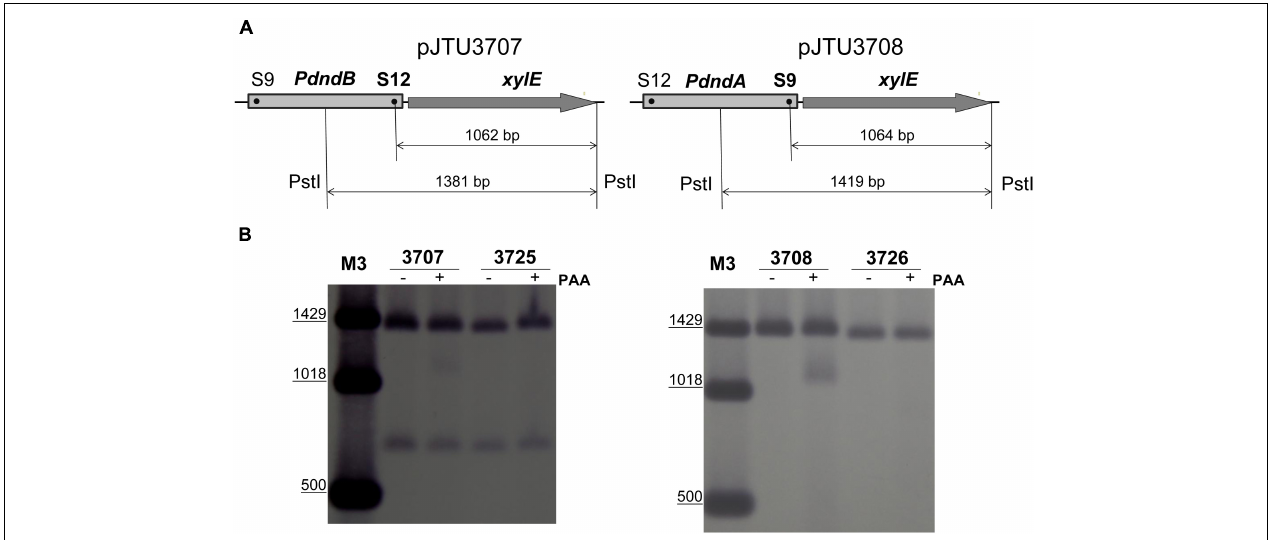
FIGURE 2 | Validation of S9 and S12 sulfur-modified sites. (A) Validation scheme for the S9 and S12 sulfur-modified sites. Genomic DNA samples from 1326/pJTU3707, 1326/pJTU3725, 1326/pJTU3708, and 1326/pJTU3726 were, respectively, subjected to digestion with Pst I, followed by treatment with PAA. pJTU3707, PdndB-xylE reporter plasmid; pJTU3725, pJTU3707 derivative with mutation in S12 site; pJTU3708, PdndA-xylE reporter plasmid; pJTU3726, pJTU3708 derivative with mutation in S9 site. (B) The effect of mutation in S9 or S12 site on DNA degradation. After digestion with Pst I and treatment with PAA, DNA was separated on 0.7% agarose gel, and Southern blotting was performed. “+” indicates PAA treatment; “ − ” indicates no PAA treatment. DNA markers for Southern blotting are labeled as “M3.”